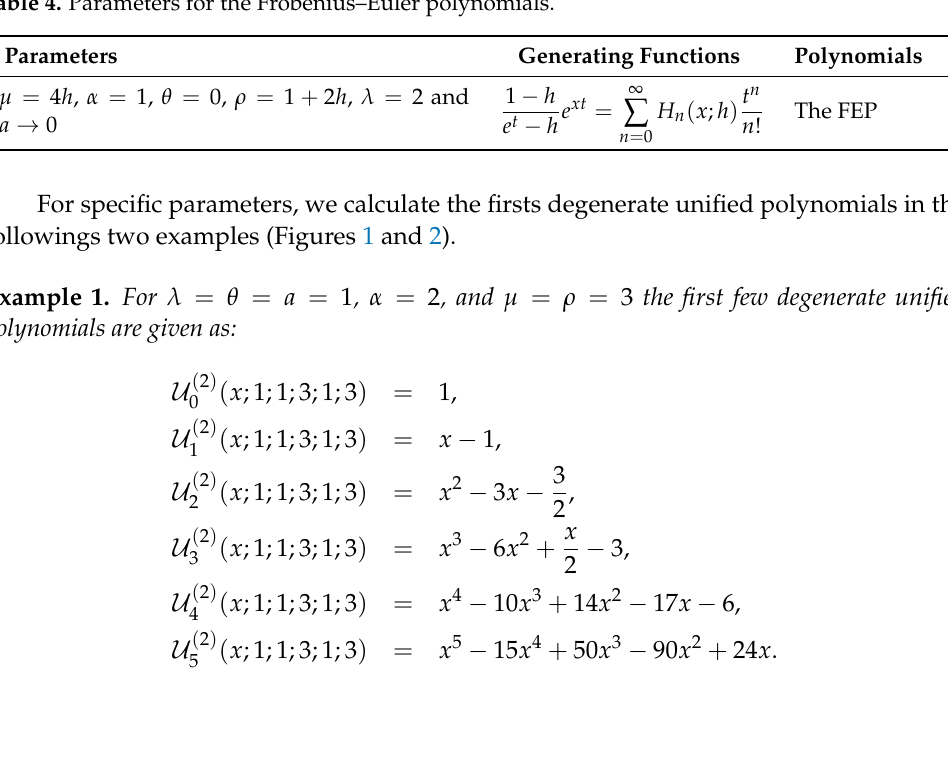
Table 4. Parameters for the Frobenius–Euler